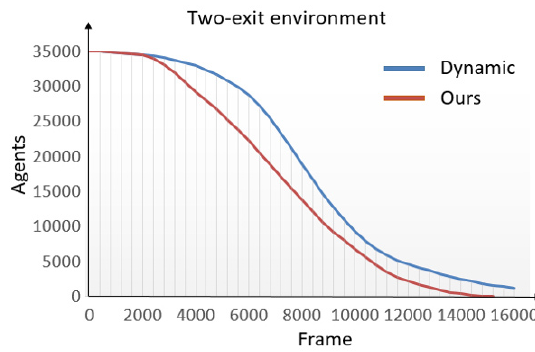
Fig. 26 Number of remaining agents in the two-exit environment. Our method performs better than the dynamic method